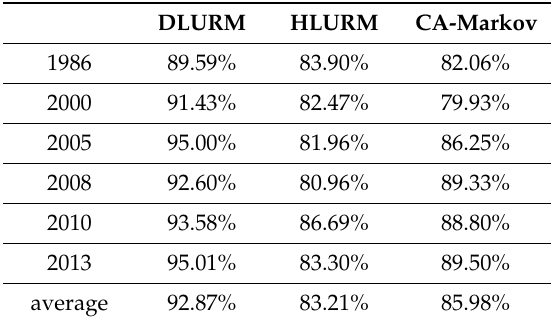
Table 3. Overall accuracy.